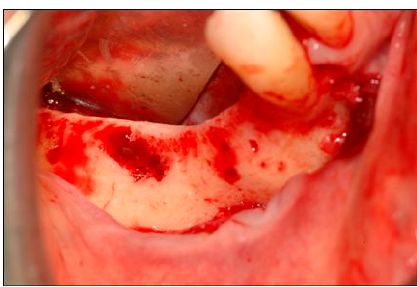
Figure 4. The mucoperiostial flap was elevated to expose the alveolar ridge.